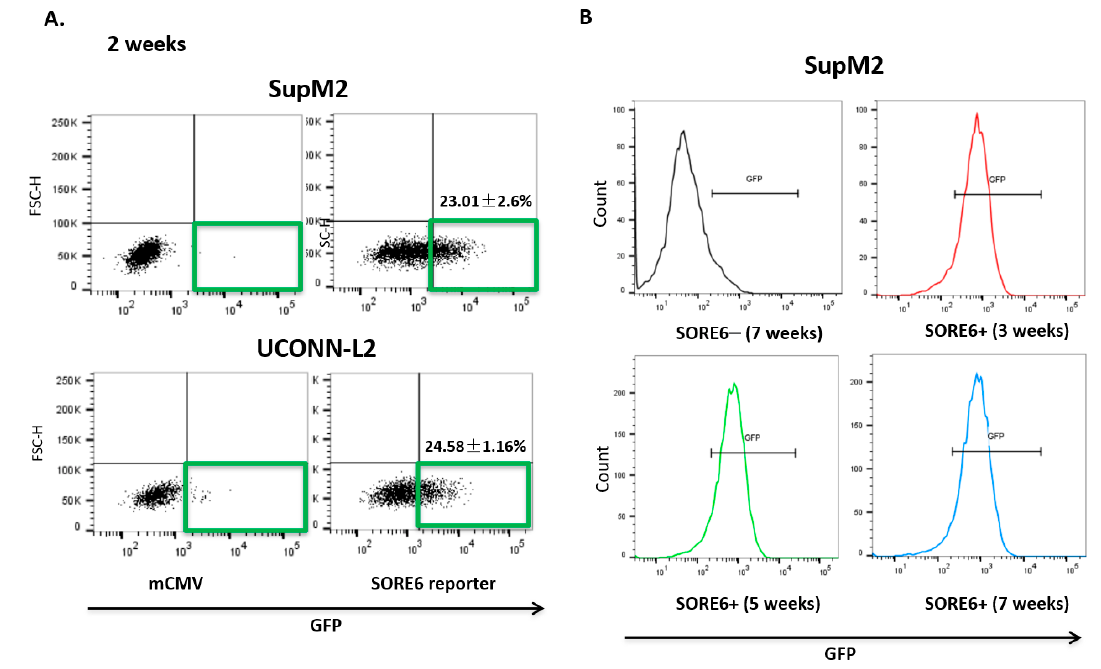
Figure 2. SORE6 reporter is transcriptionally active in relatively small subsets of ALK + ALCL cells. ( A ) mCMV and SORE6 reporters were introduced to two ALK+ ALCL cell lines, SUPM2 and UCONN-L2. The gated region shows the proportion of cells that were positive for green fluorescent protein (GFP) expression, both SupM2 and UCONN-L2 cells were detected by flow cytometry after puromycin selection 7 days. ( B ) Analysis of GFP levels in SupM2 SORE6+ cells over the course for 3, 5, and 7 weeks by flow cytometry. SupM2 SORE6 − cells at 7 weeks were included as a gating control.